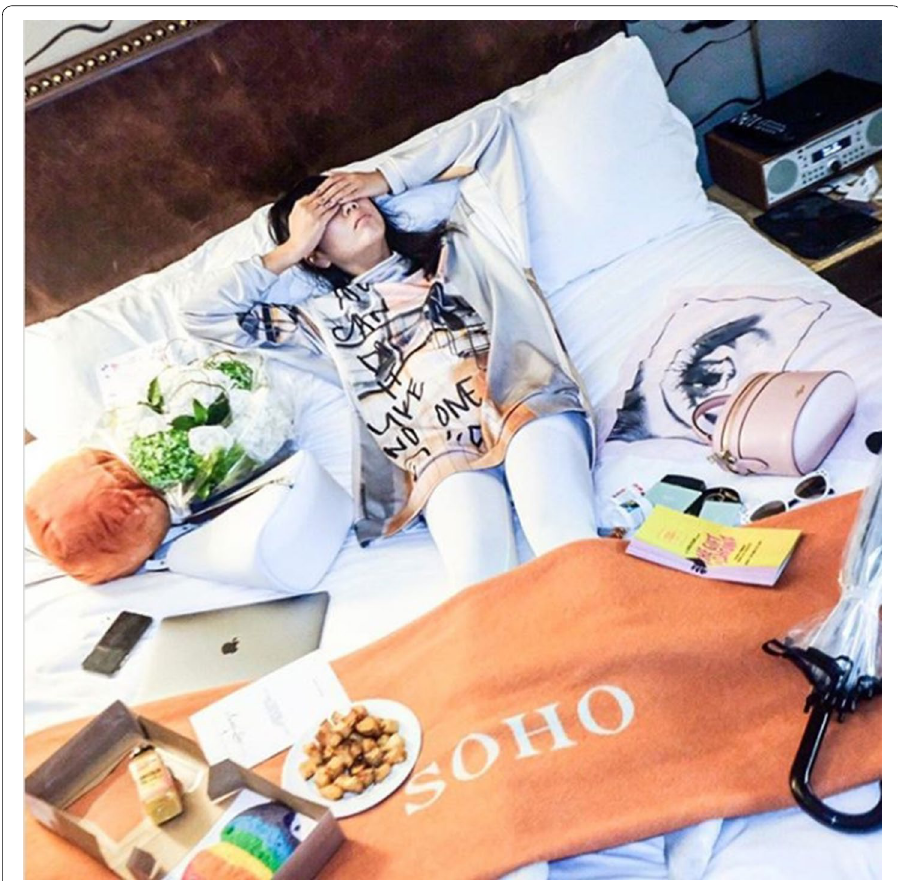
Fig. 1 Soho Grand Hotel. https ://www.insta gram.com/p/Bnqbm MJhvE v/. Accessed 5 September